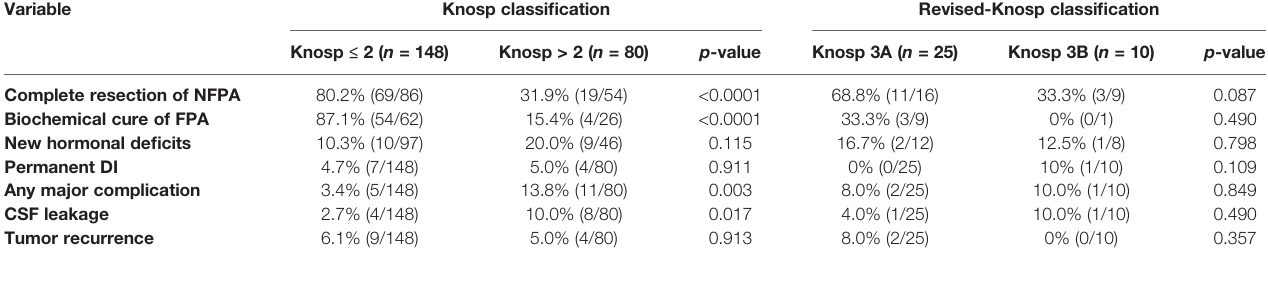
TABLE 3 | Surgical outcomes according to cavernous sinus invasion based on Knosp and revised-Knosp classi fi cations. Variable